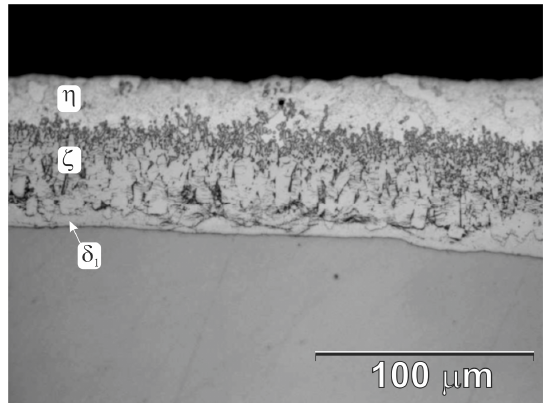
Figure 5. The structure of the zinc hot-dip coating used as a comparative coating in the NSS test.